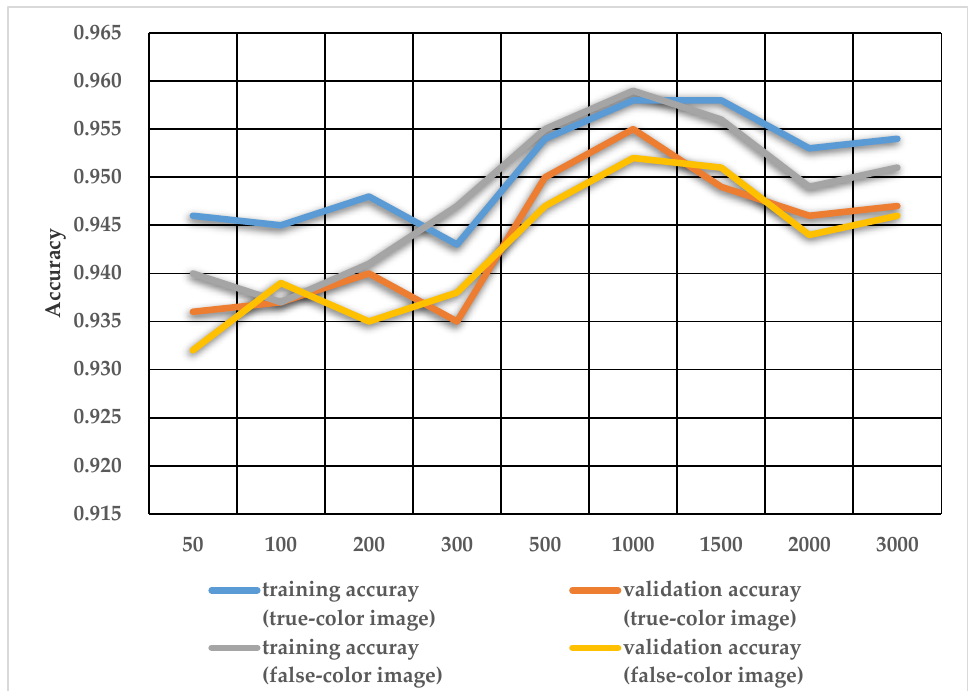
Figure 8. Training and validation accuracies of the true-color image and false-color image under four different ratios of training and validation samples.